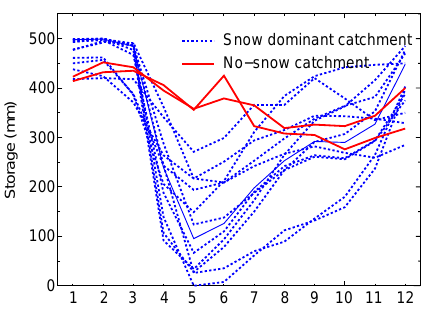
Figure A4. Seasonal water balance for precipitation corrected data